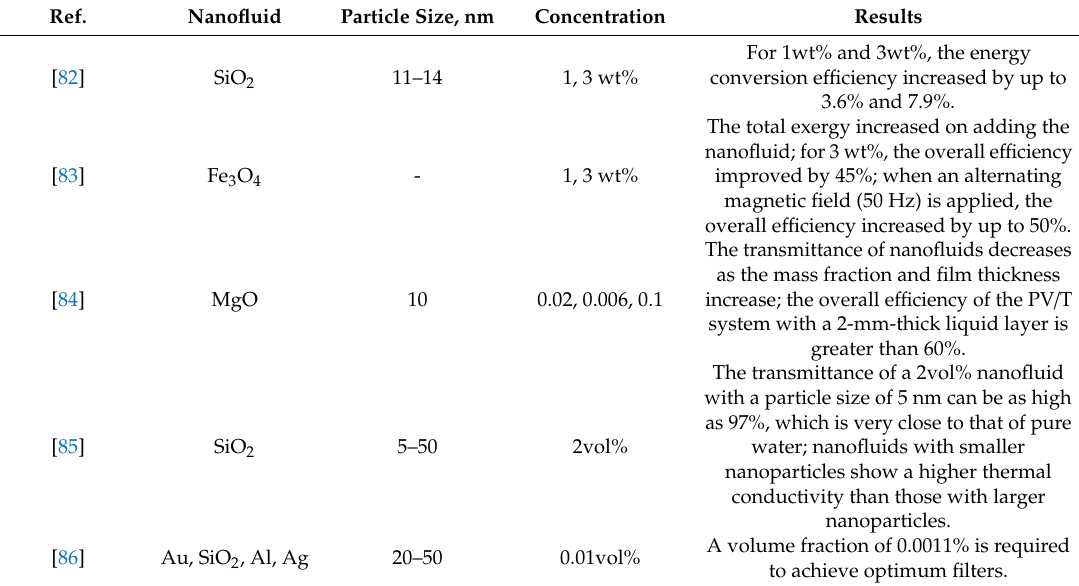
Table 5. Summary of performance of nanofluid-based PV / T systems [81]; 2019, IAES.